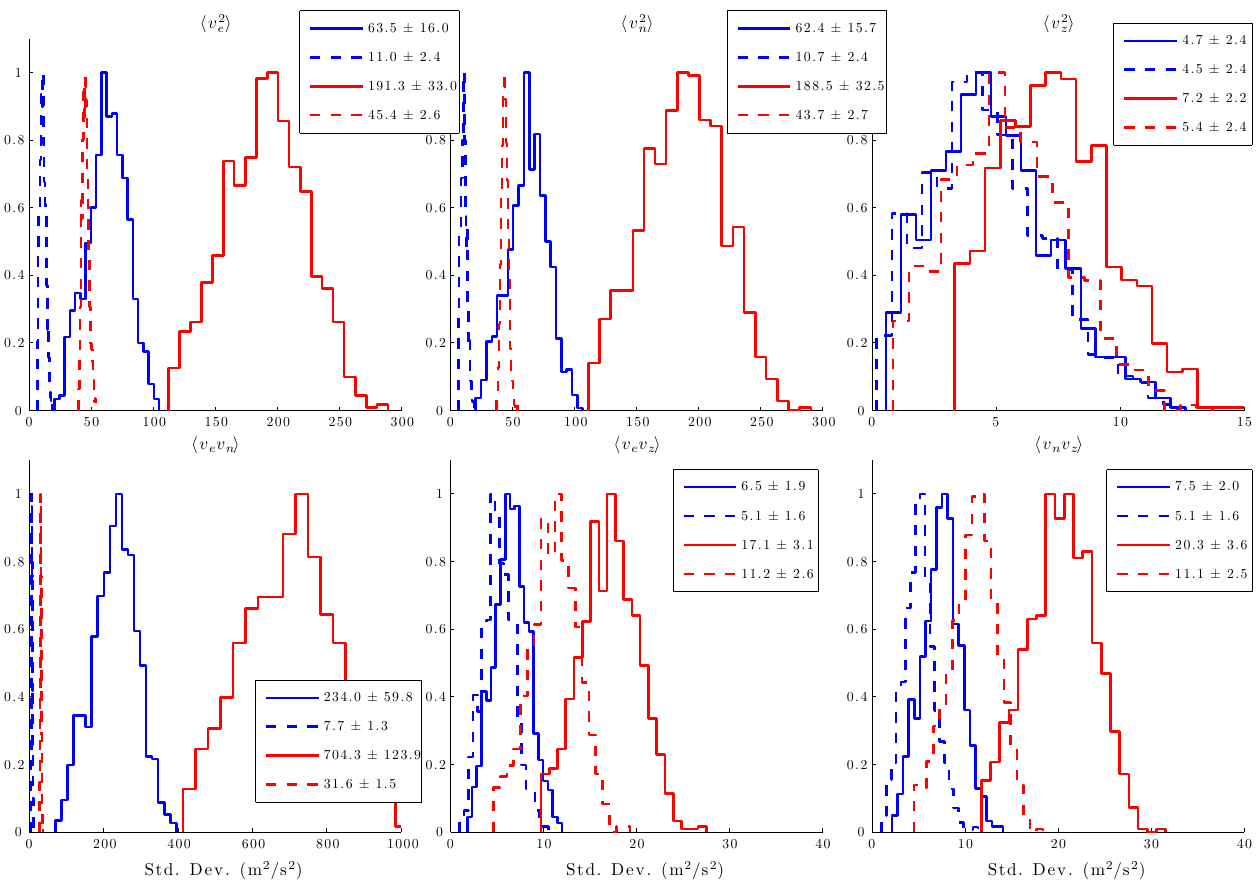
Fig. 4. Similar to Fig. 3, except curves correspond to histograms of standard deviations of wind variance and momentum flux estimates, computed over the N 2